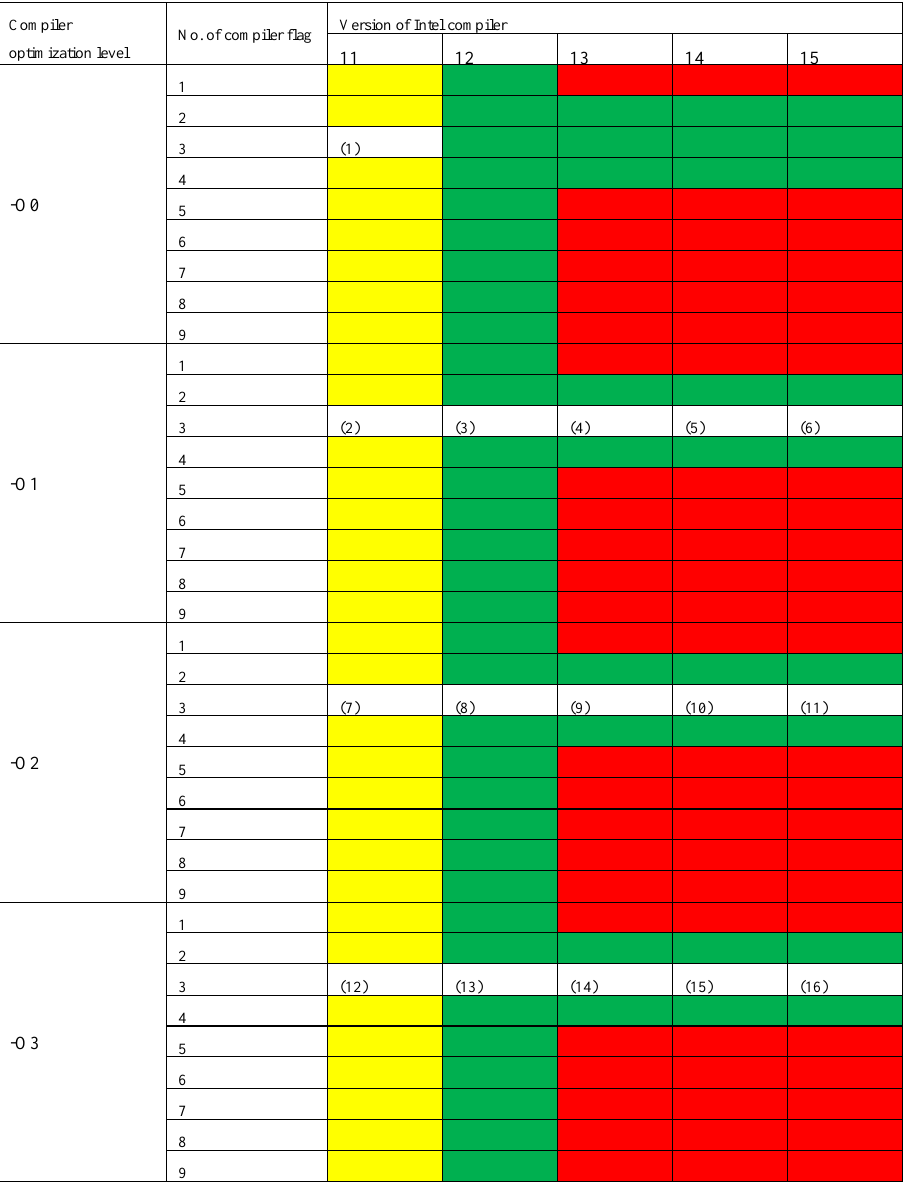
Table 10. Similar to Table 8 except for the simulation results of FGOALS-g2. Table 10: Similar to Table 8 except for the simulation results of FGOALS-g2.